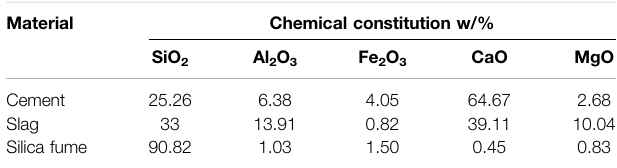
TABLE 1 | Chemical constitution of PI 42.5 Portland cement, slag, fl y ash, and silica fume w/%. Material